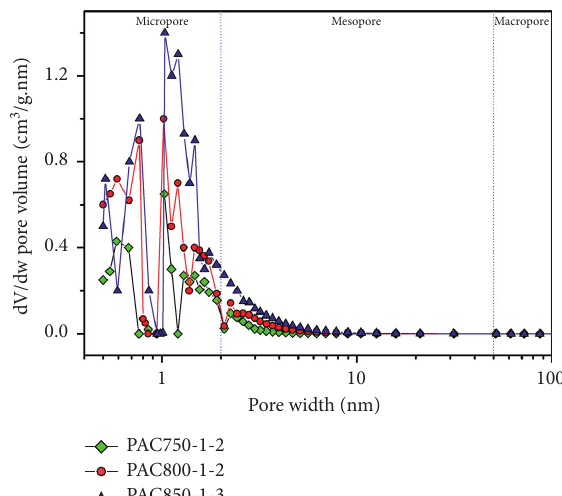
Figure 2: Pore size distribution of